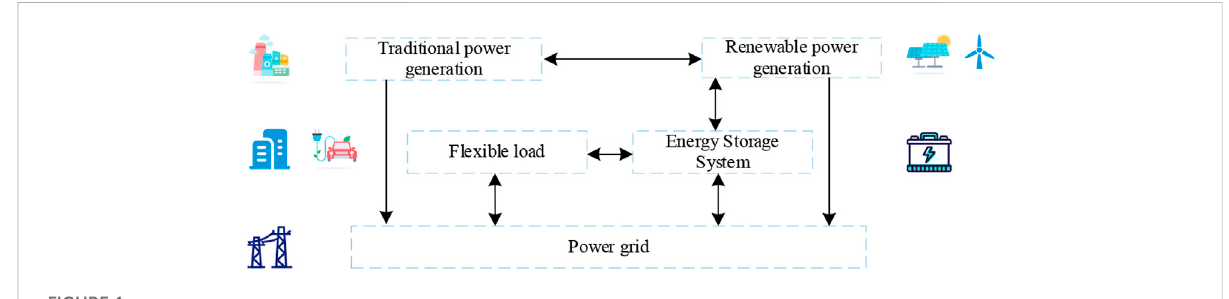
FIGURE 1 Diagram of source – grid – load – storage interaction.